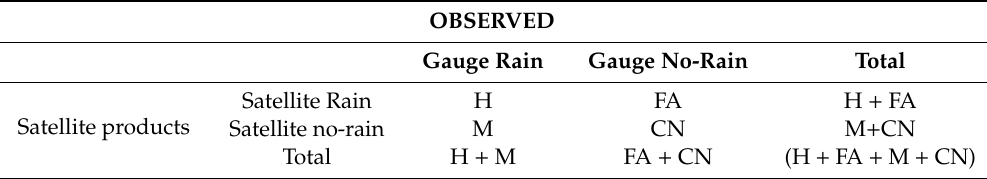
Table 2. Contingency table showing the joint distribution of satellite products and OBSERVED